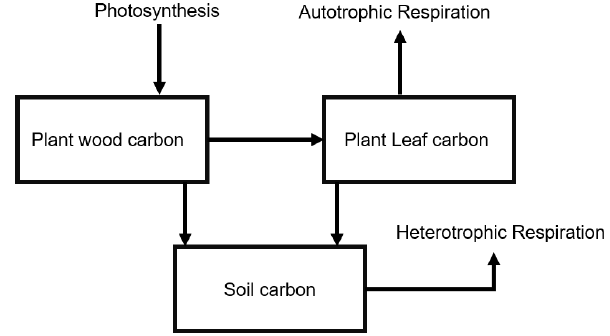
Figure 1. Carbon cycle representation by the SIPNET